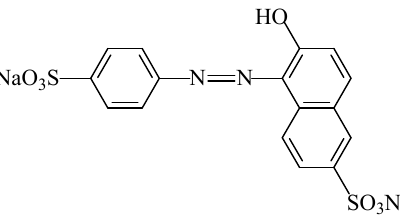
Figure 17. Structural formula of the sunset yellow FCF food colouring (E110). Like other azo food colours, yellow-orange S is usually present as a sodium salt, but potassium and calcium salts are also